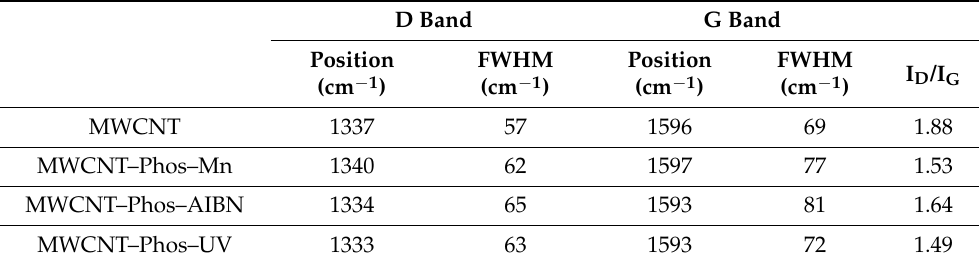
Table 2. Raman mode positions, linewidths (FWHM), and I D /I G ratios for MWCNT, MWCNT–Phos–